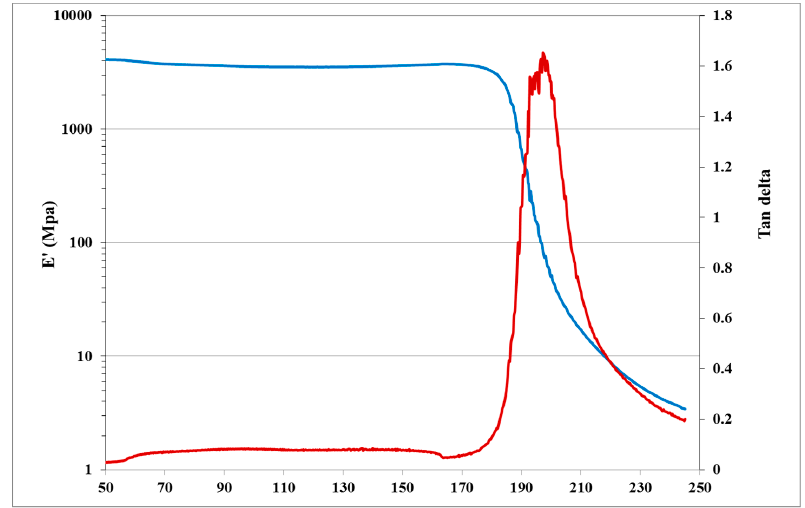
Figure 11. Evolution of the storage modulus (red curve) and tan δ (blue curve) as a function of time for PEEKN5 .